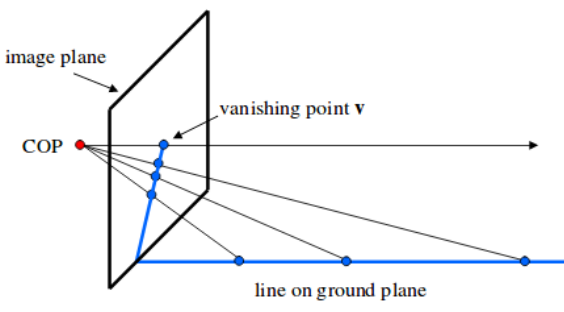
Figure 11. Ground Hypothesis assumes all objects are on the floor.